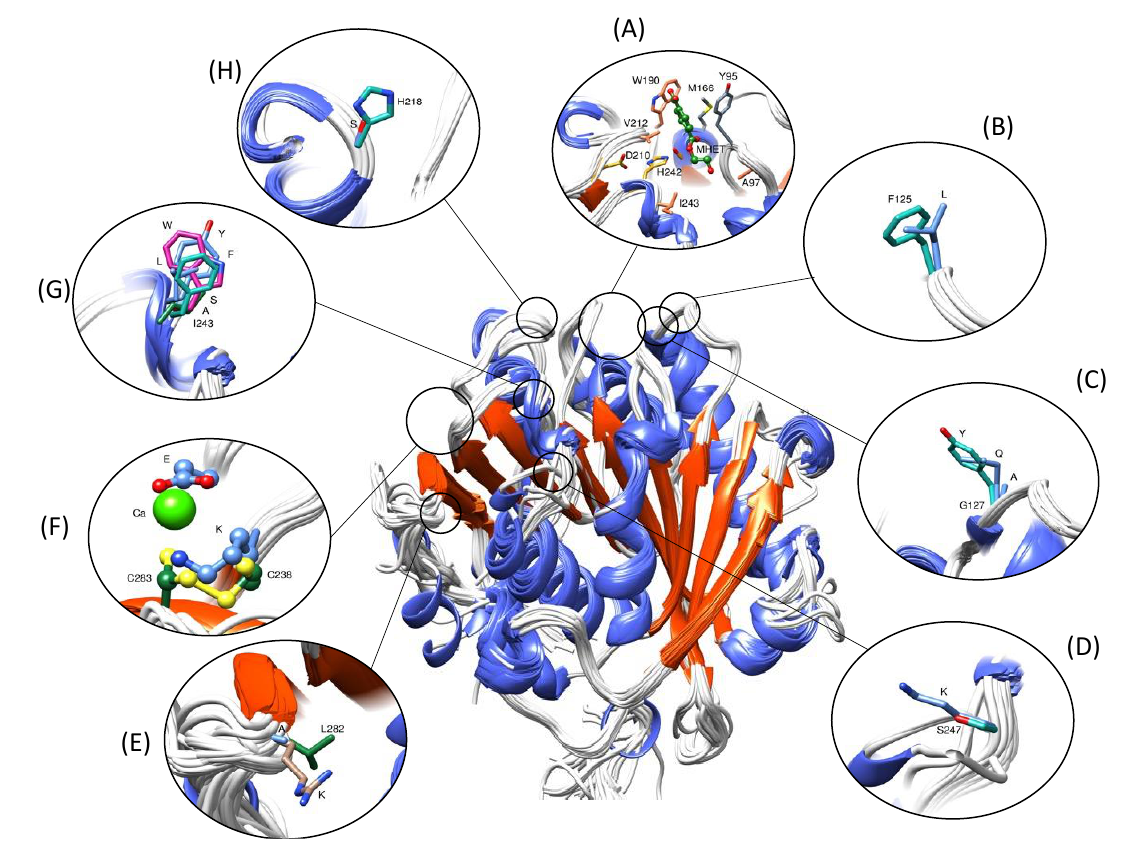
Figure 3. Some mutation hot spots were documented on the superposed crystal structures, with 3D models created by AlphaFold 2.0 (Supplementary Table S1), of known hydrolases. The backbone of the LCC-ICCG complex with MHET (7VVE), was superposed with other homologs. ( A ) The catalytic triad (S165, H242, and D210), oxyanion holes (Y95, M166), and residues that contributed to the MHET binding (W190, V212, I243, H242, H164, A97, M166, and Y95) [96]. ( B ) F125 is a possible target to mutate; Leucine is present in another PET hydrolase [50]. ( C ) G197 is a mutation hot spot, equivalent to Y197 in LCC [112], A138 [78], and Q94 [50]. ( D ) S247 is a residue far from the active site, changed to lysine [109]. ( E ) L282 is a distant residue from the active site, equivalent to a lysine in Is PETase [41], and mutated to alanine [42]. ( F ) Strategies to improve thermostability: a disulfide